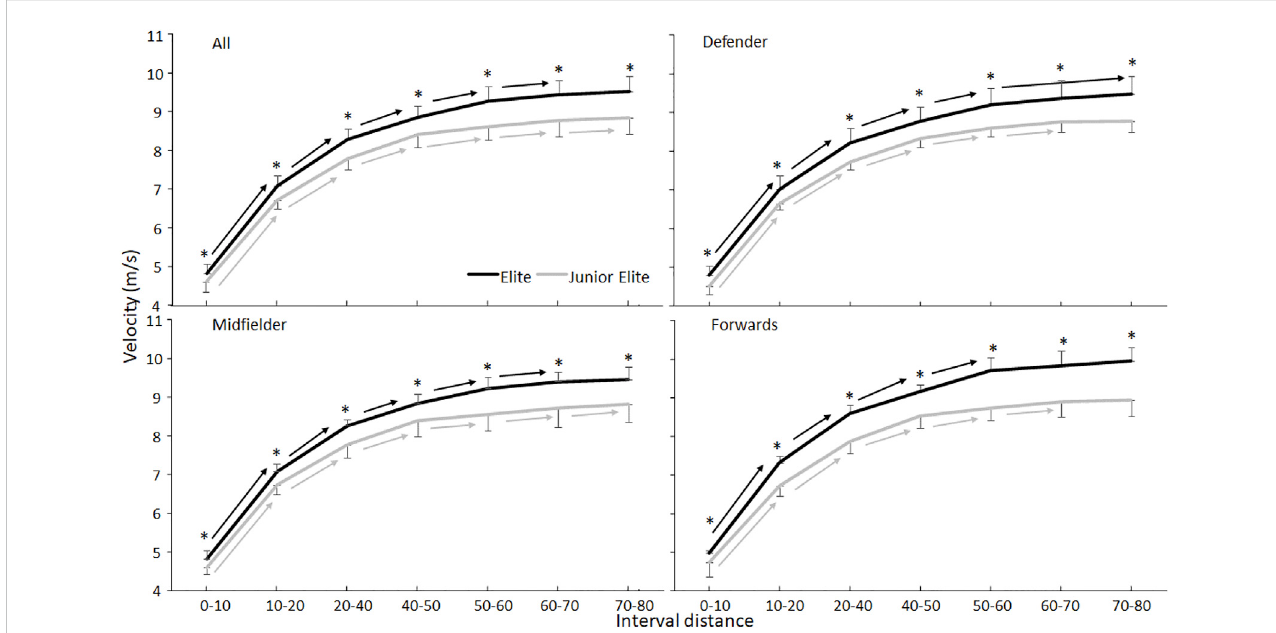
FIGURE 1 Mean velocity (SD) over 10 m distances averaged for all elite and junior players and per position in elite and junior players. * indicates a signi fi cant difference between elite and junior players atthisinterval distanceon a p < 0.05 level. → indicates a signi fi cant increase invelocitybetweenthese two interval distances and all right of the arrow for this group on a p < 0.05